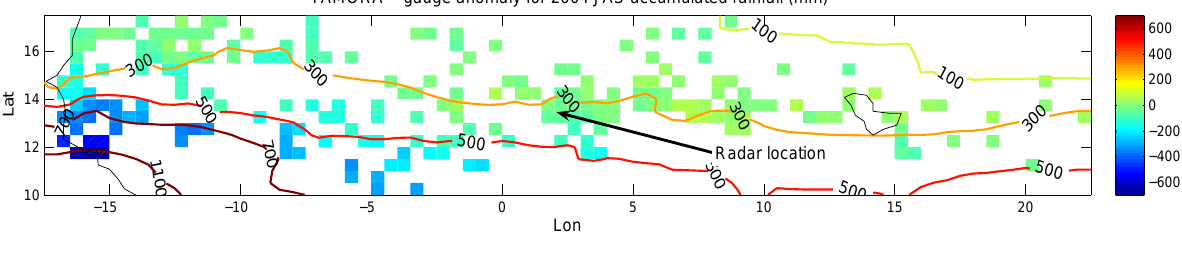
Fig. 2. TAMORA - Kriged Gauge anomaly for accumulated JAS 2004 rainfall (shown by coloured pixels). Only pixels containing at least one gauge are shown. Contours show accumulated JAS 2004 rainfall from kriged gauges (mm). West African coastline and Lake Chad are depicted by black lines, and location of AMMA radar in 2006 is also shown.